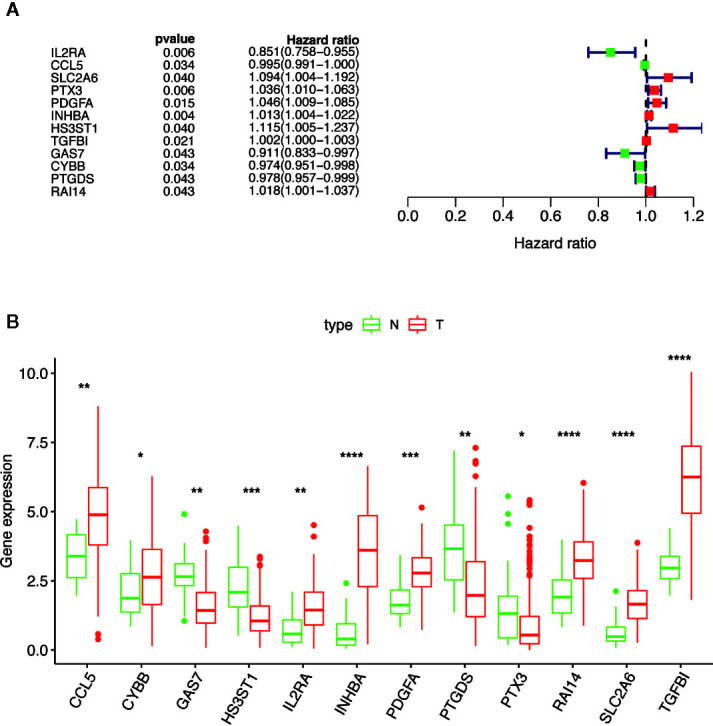
Selection of 12 MGMs associated with the OS of HNSCC patients by univariate Cox regression analysis. (A) Univariate Cox regression analysis. Forest plot of 12 MGMs associated with survival. (B) Differential expression of the 12 MGMs between 24 tumor-adjacent tissues and 250 HNSCC tissues. Note: *P < 0.05, **P < 0.01, ***P < 0.001, ****P < 0.0001.